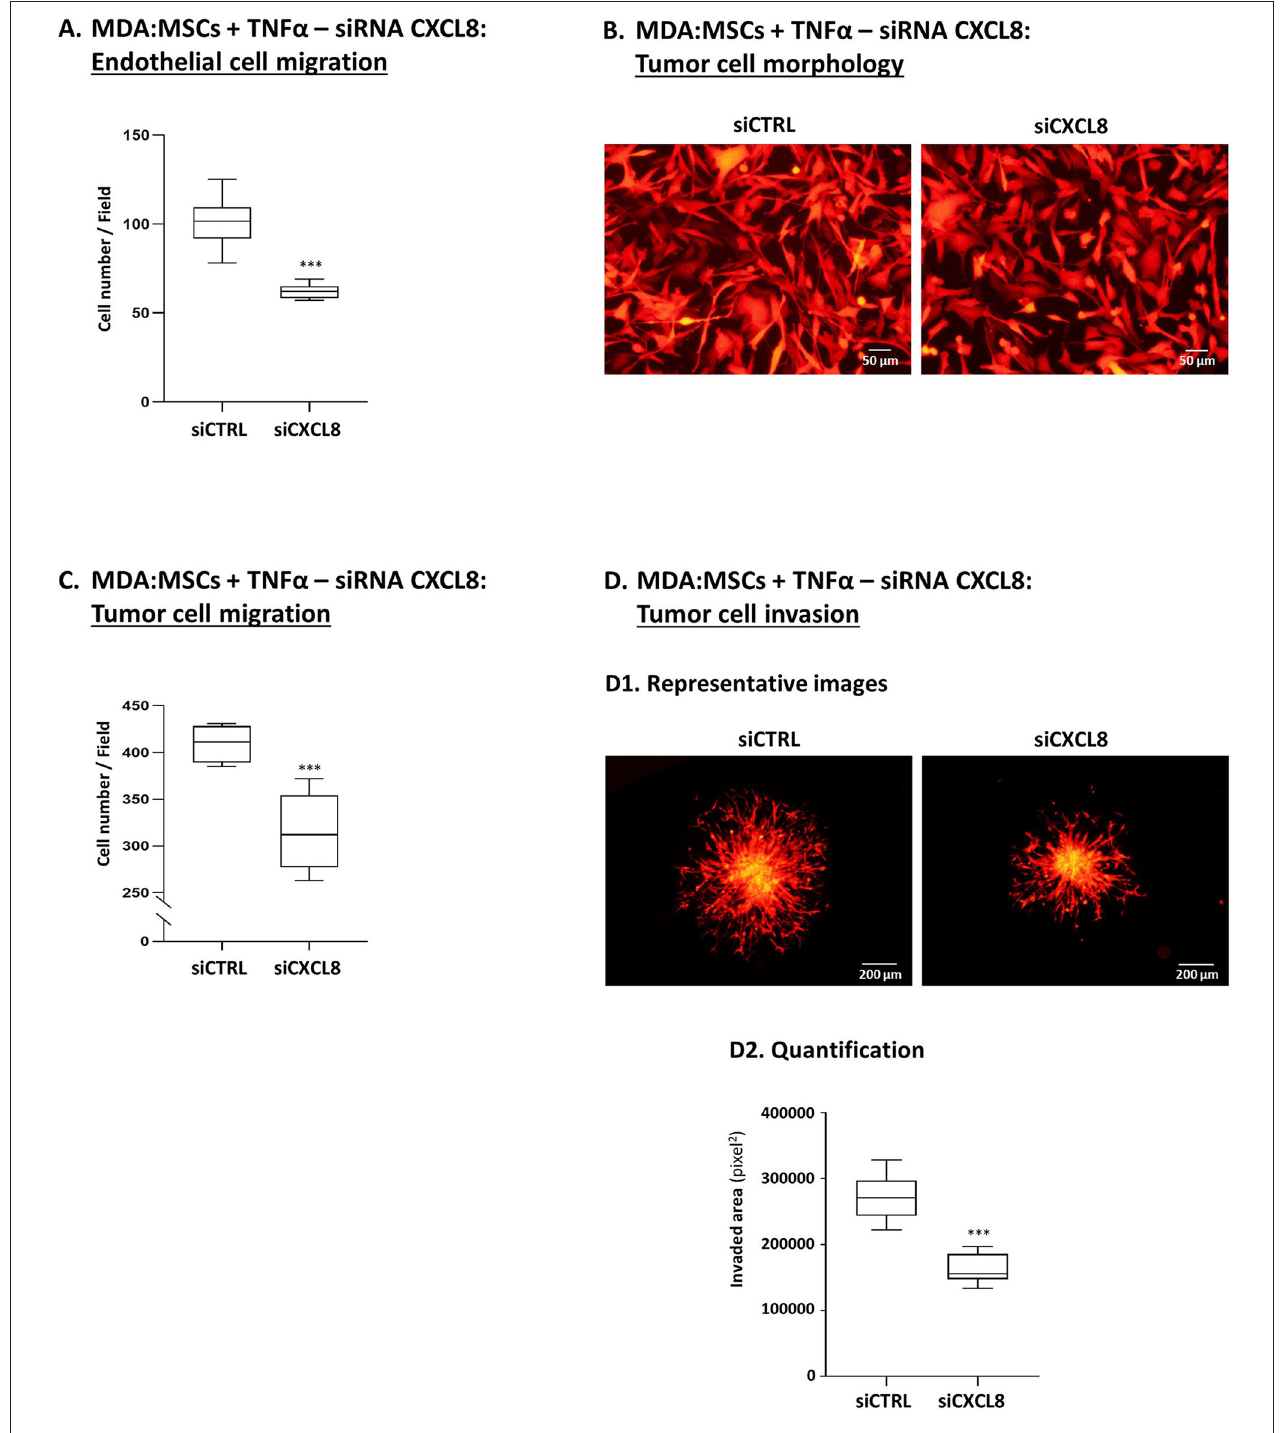
FIGURE 12 | Tumor-stroma-inflammation networks lead through CXCL8 activities to increased angiogenesis, invasion-related tumor cell morphology, tumor cell migration and invasion in TNBC cells. MDA-MB-231 cells (“MDA”) and MSCs were both transfected by siCXCL8 or siCTRL. Parallel studies indicated that the efficiency of CXCL8 down-regulation was high [80–90% in most experiments, as in (80); Data not shown]. The cells were grown in “Contact” co-cultures and were stimulated by TNF α (10ng/ml); then, the cells or their CM were assayed in the following tests: (A) Endothelial cell migration (Procedures as in Figure 8A ). *** p < 0.001; (B) Tumor cell morphology (Procedures as in Figure 9A1 ). Bar, 50 µ m; (C) Tumor cell migration (Procedures as in Figure 9A2 ). *** p < 0.001; (D) Tumor cell invasion (Procedures as in Figure 10 ). (D1) Representative photos. Bar, 200 µ m. (D2) Quantification. *** p < 0.001. In all parts of the Figure, photos and their quantifications are representatives of n = 3 independent experiments, performed with MSCs of 2 different donors.